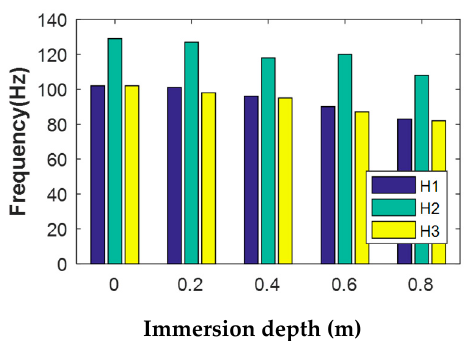
Figure 28. The first natural frequency of the tank when 2.1 kg of mass is added to the three substructures, under the scenario of multiple damages (V =